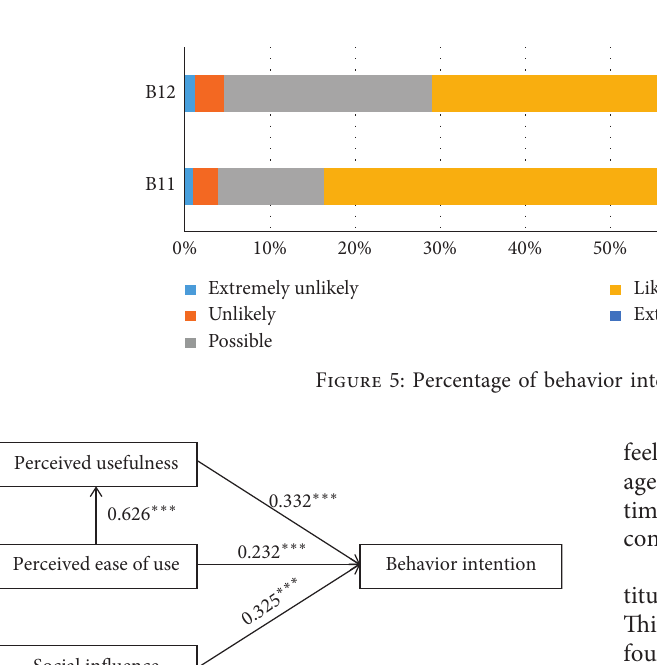
Figure 4: Percentage of social influence on using Robo-taxis.